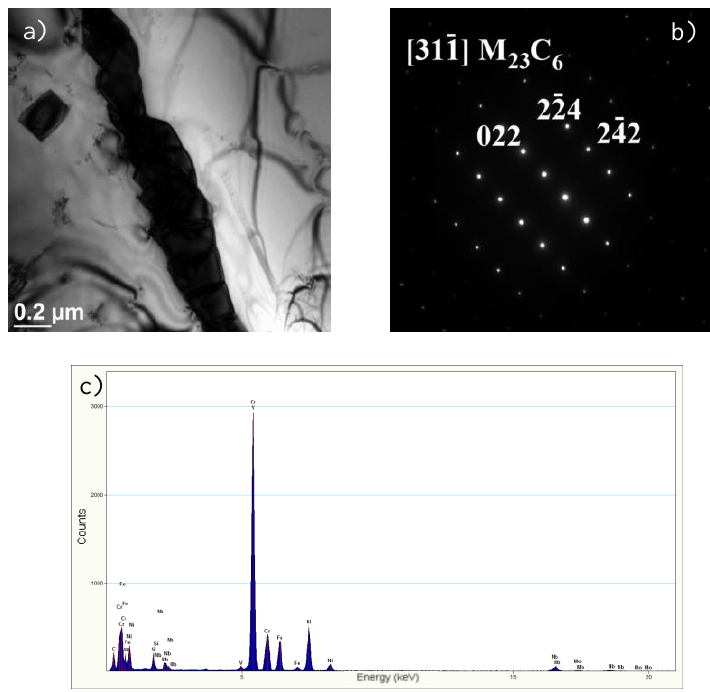
ff raction ( b ), EDS analysis ( c ); TEM.